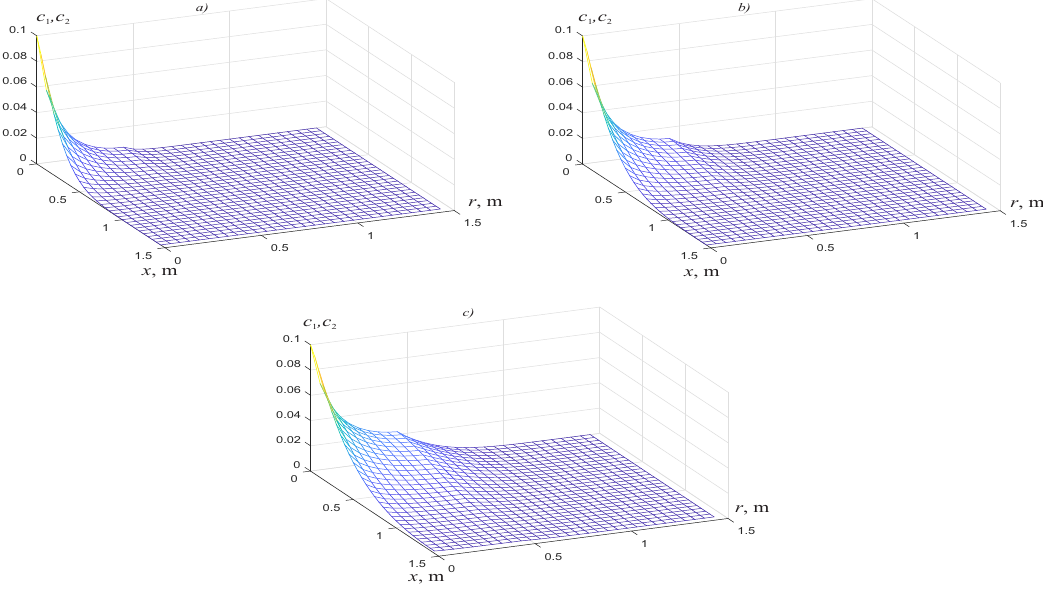
= 2, γ = 1, γ ∗ = 2, D = 5 · 10 − 5 m γ ∗ 1 /s, 2 1 x 2 1